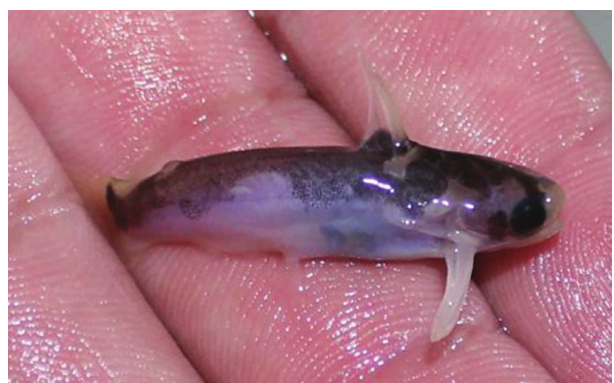
Fig. 2. Life coloration of specimen of Tatia melanoleuca collected in rio Jamanxim, tributary to upper rio Tapajós basin. Photograph courtesy of Heriberto Gimenes Junior.